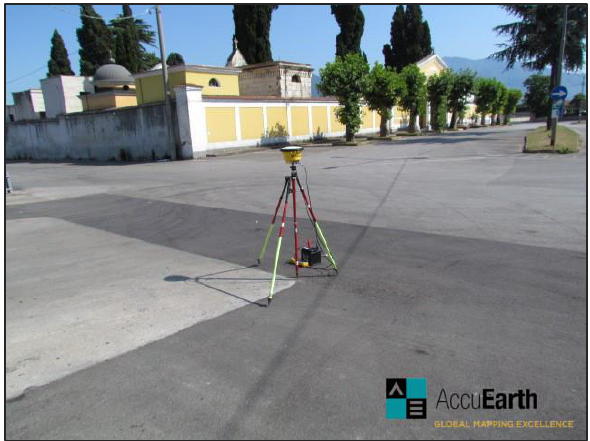
Figure 3. Asphalt and Concrete - different shades of Grey